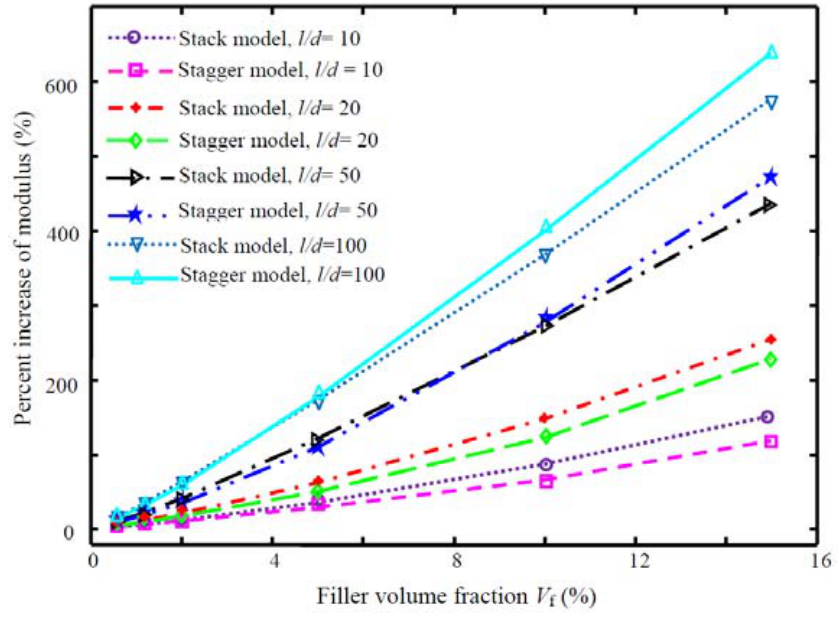
Figure 16. Variation of the percent increase of effective modulus (compared to matrix) with the filler volume fraction V f for different clay-particle aspect ratios ρ = 10, 20, 50 and 100.